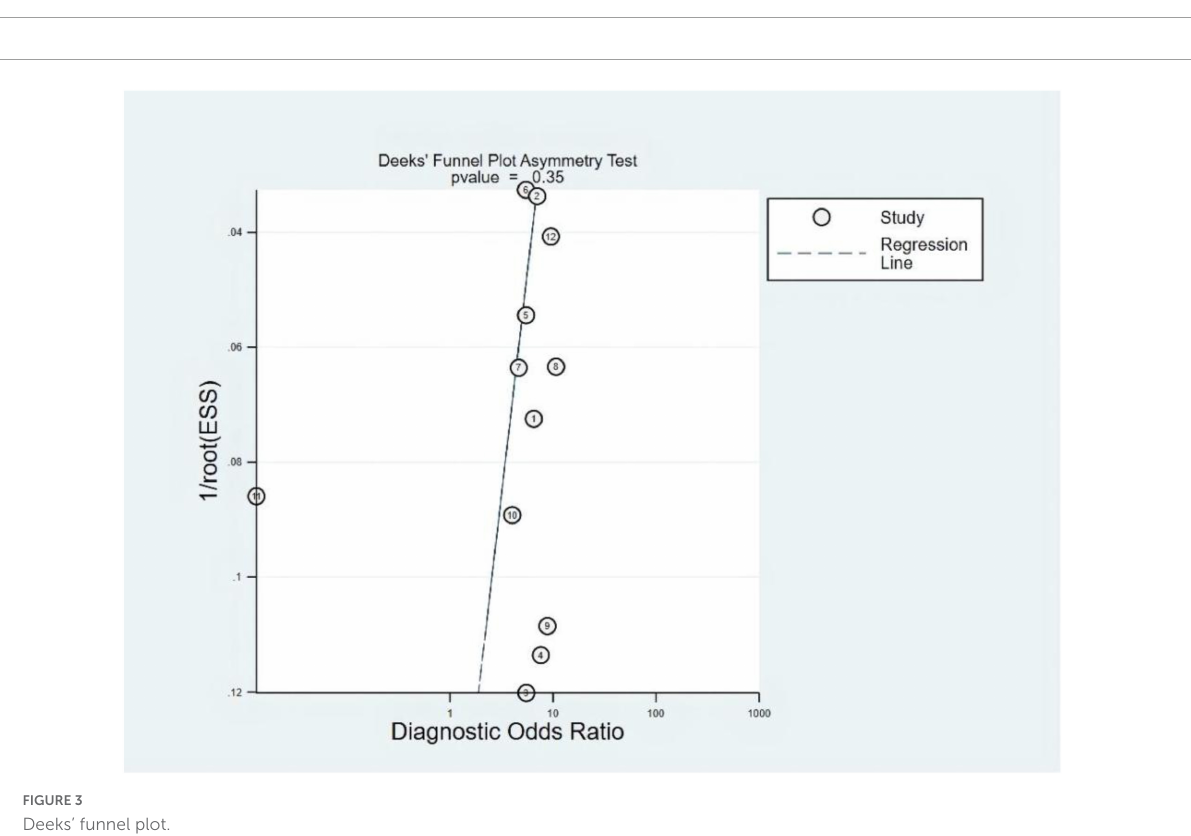
FIGURE3 Deeks’ funnel